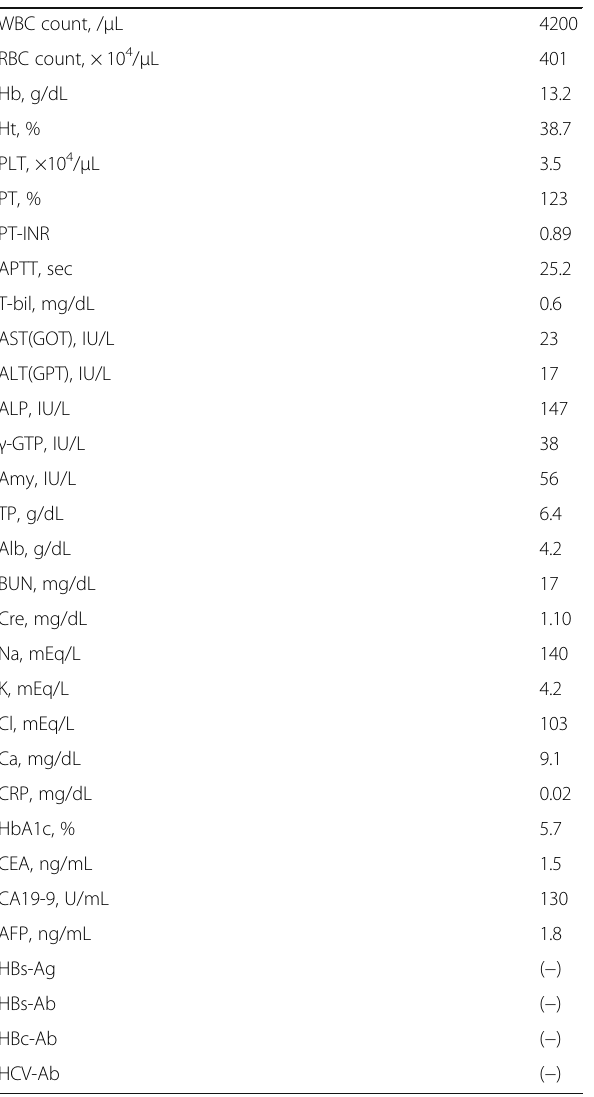
Table 1 Laboratory data on